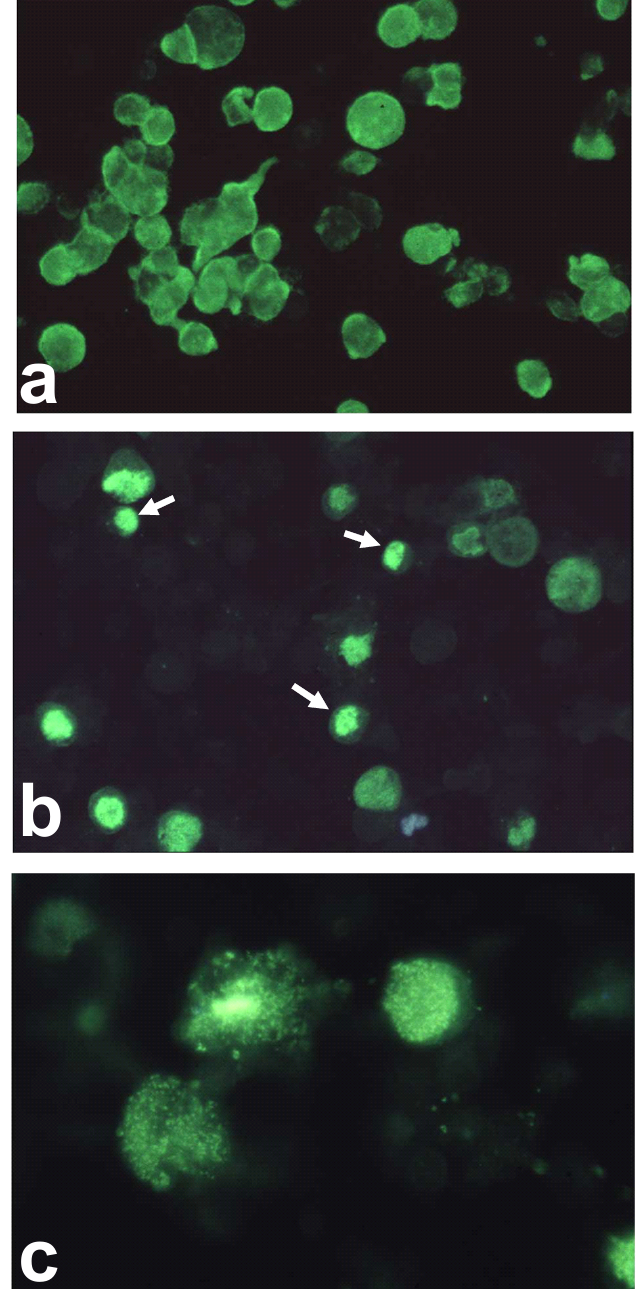
Figure 2. Immunofluorescent assay. ( a ) RSIV-infected Grunt Fin (GF) cells were incubated with monoclonal antibody M10 and ballooned, infected cells were identified by the presence of diffuse staining throughout the cell; ( b ) RSIV-infected GF cells were incubated with polyclonal rabbit anti-RSIV serum which detects structural proteins. In contrast to panel A, staining is seen only within viral assembly sites. Viral assembly sites are indicated by arrows. The assembly site becomes granulated and is gradually dispersed throughout the whole cell (Panel c); ( c ) Higher magnification of stained cells filled with